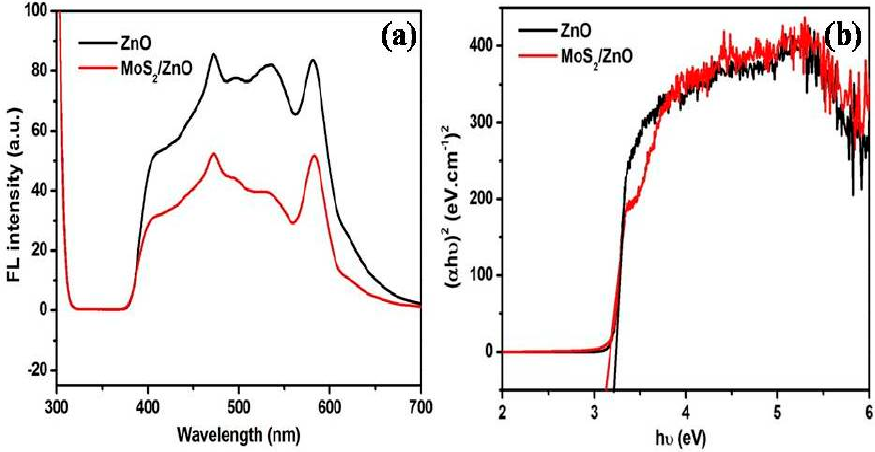
Figure 6. ( a ) Room temperature FL spectra and ( b ) Tauc’s plot of pure ZnO nanoparticles and MoS 2 /ZnO heterostructure nanorods.